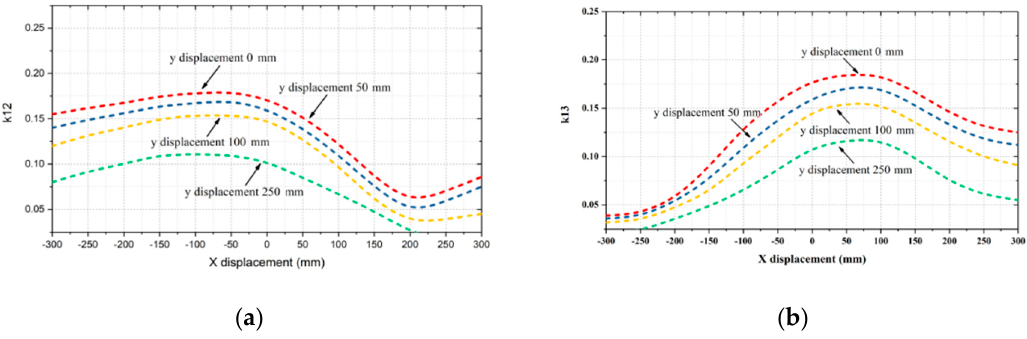
Figure 9. Variation of total coupling coefficient: ( a ) k 12 with displacement; ( b ) k 13 with displacement.